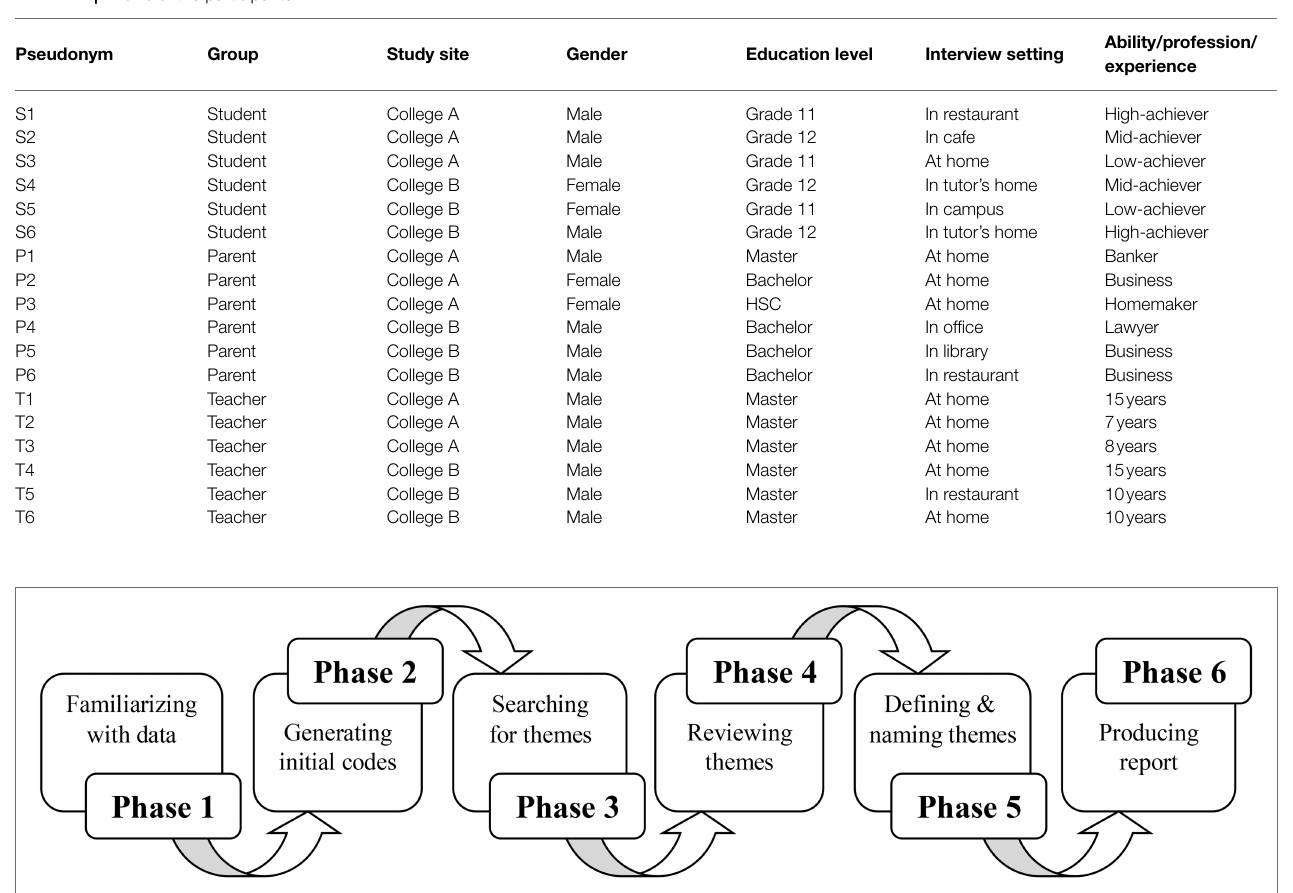
TABLE 1 | Profile of the participants.